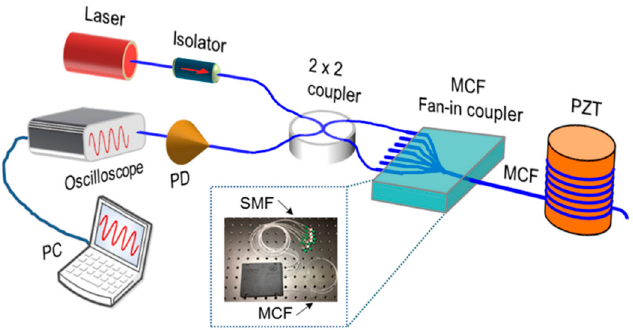
Figure 11. Experimental setup for the MMI vibration sensor [17]. PD: photodetector; PC: personal computer. The inset shows the packaged MCF fan ‐ in coupler.